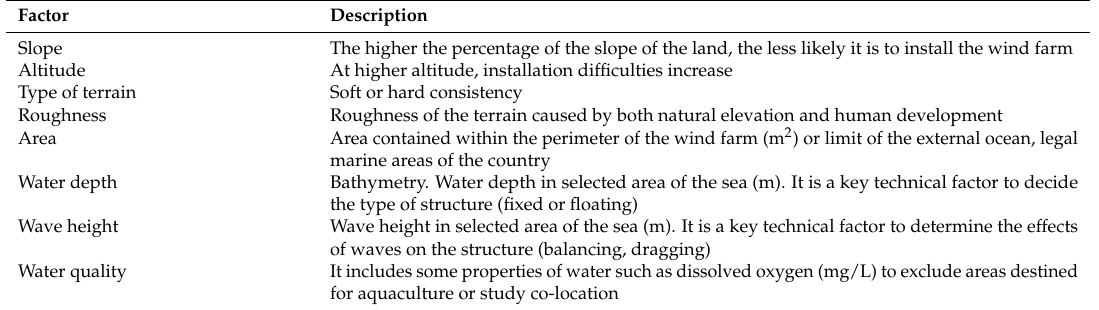
Table 2. Description of factors involved in the optimal location in the Wind farms. Geographic